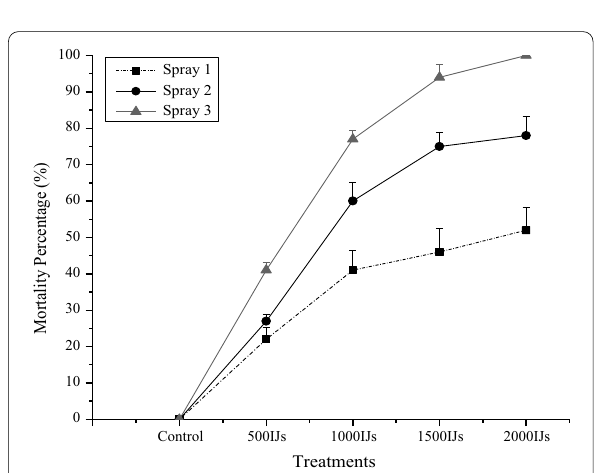
Fig. 2 Mortality percentage in Pieris brassicae larvae after three constitutive foliar applications of entomopathogenic nematodes under greenhouse